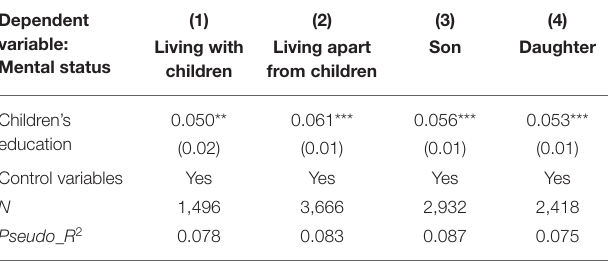
TABLE 4 | Heterogeneity analysis results.